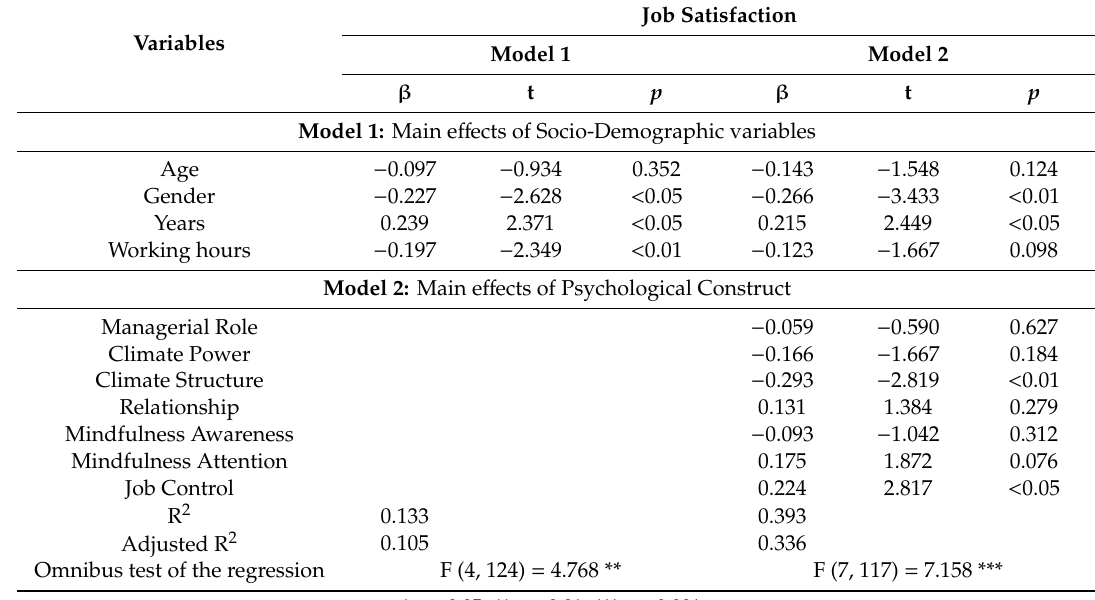
Table 3. Hierarchical regression analyses of socio-demographic variables, and factors a ff ecting job satisfaction (using 1000 bootstraps) ( n = 148).